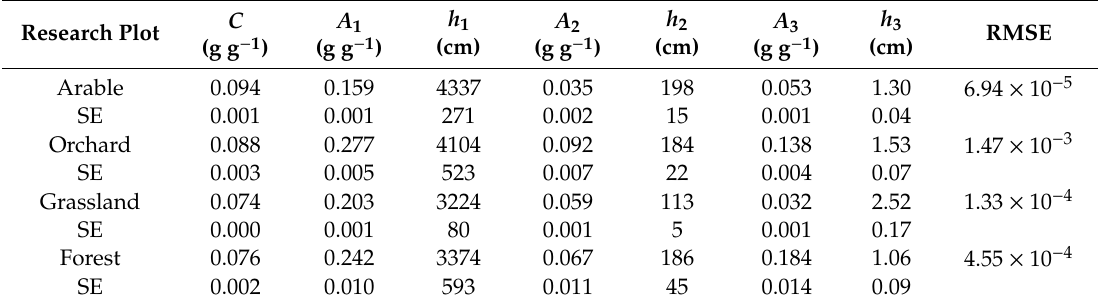
Table 2. Parameters of the triple-exponential model (Equation (4)) fitted to the average SWRCs at the four research plots.